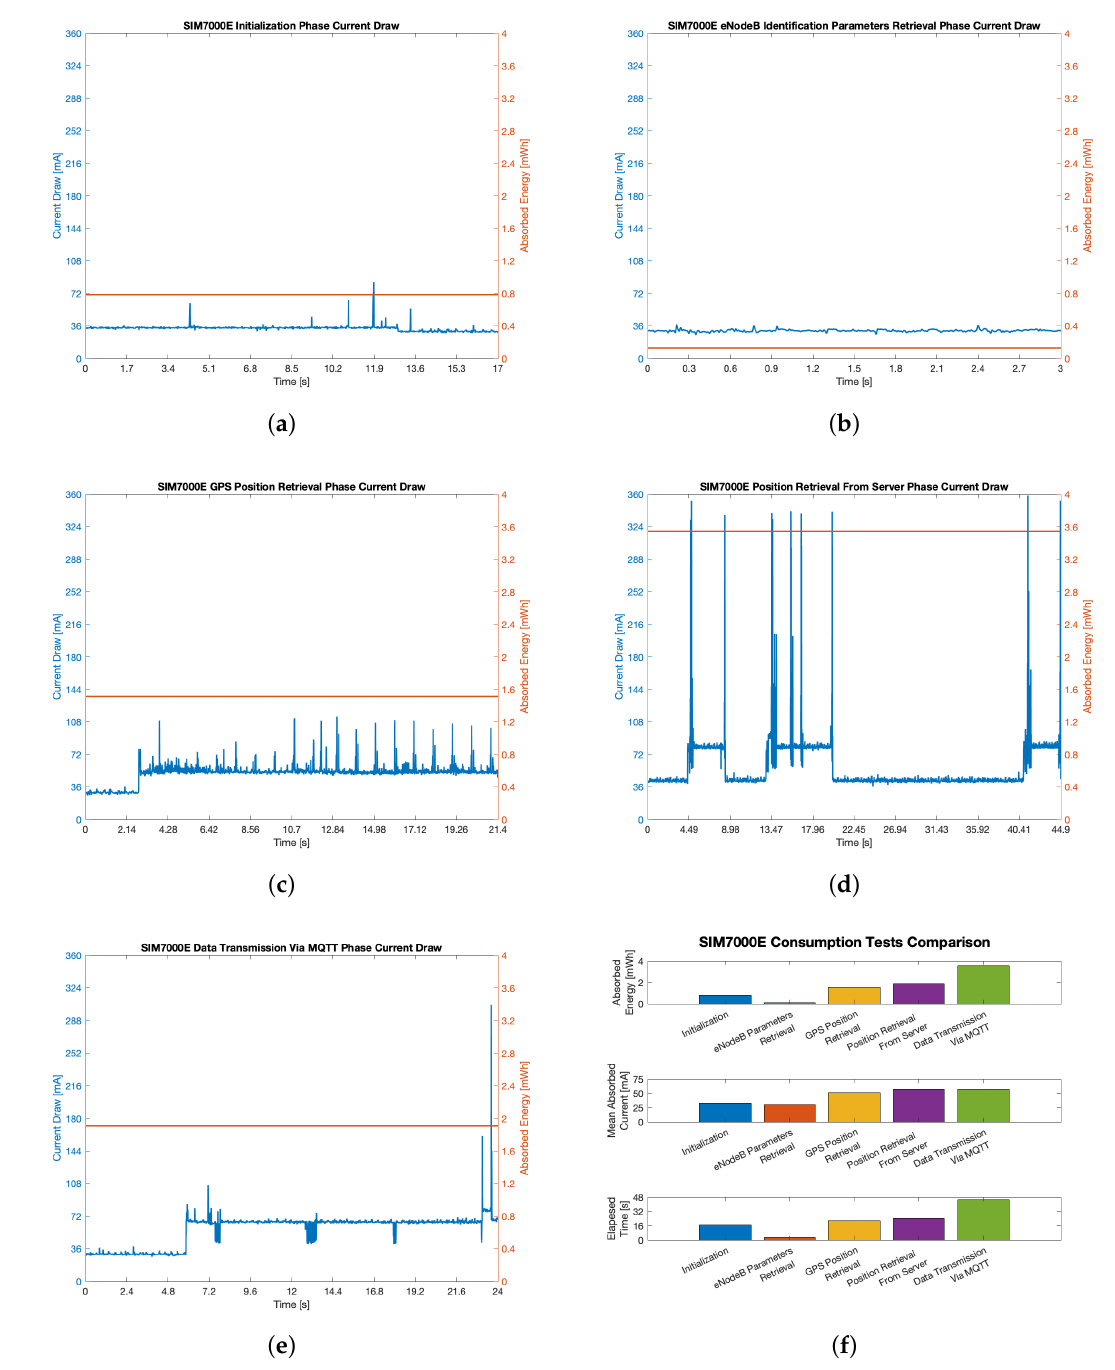
Figure 7. Consumption tests results: ( a ) Module intialization phase; ( b ) eNodeB identification parameters retrieval phase; ( c ) GPS position retrieval phase; ( d ) Position retrieval from server phase; ( e ) Data transmission via MQTT phase; ( f ) Com- parison between the aforementioned phases in terms of absorbed energy, mean absorbed power and temporal